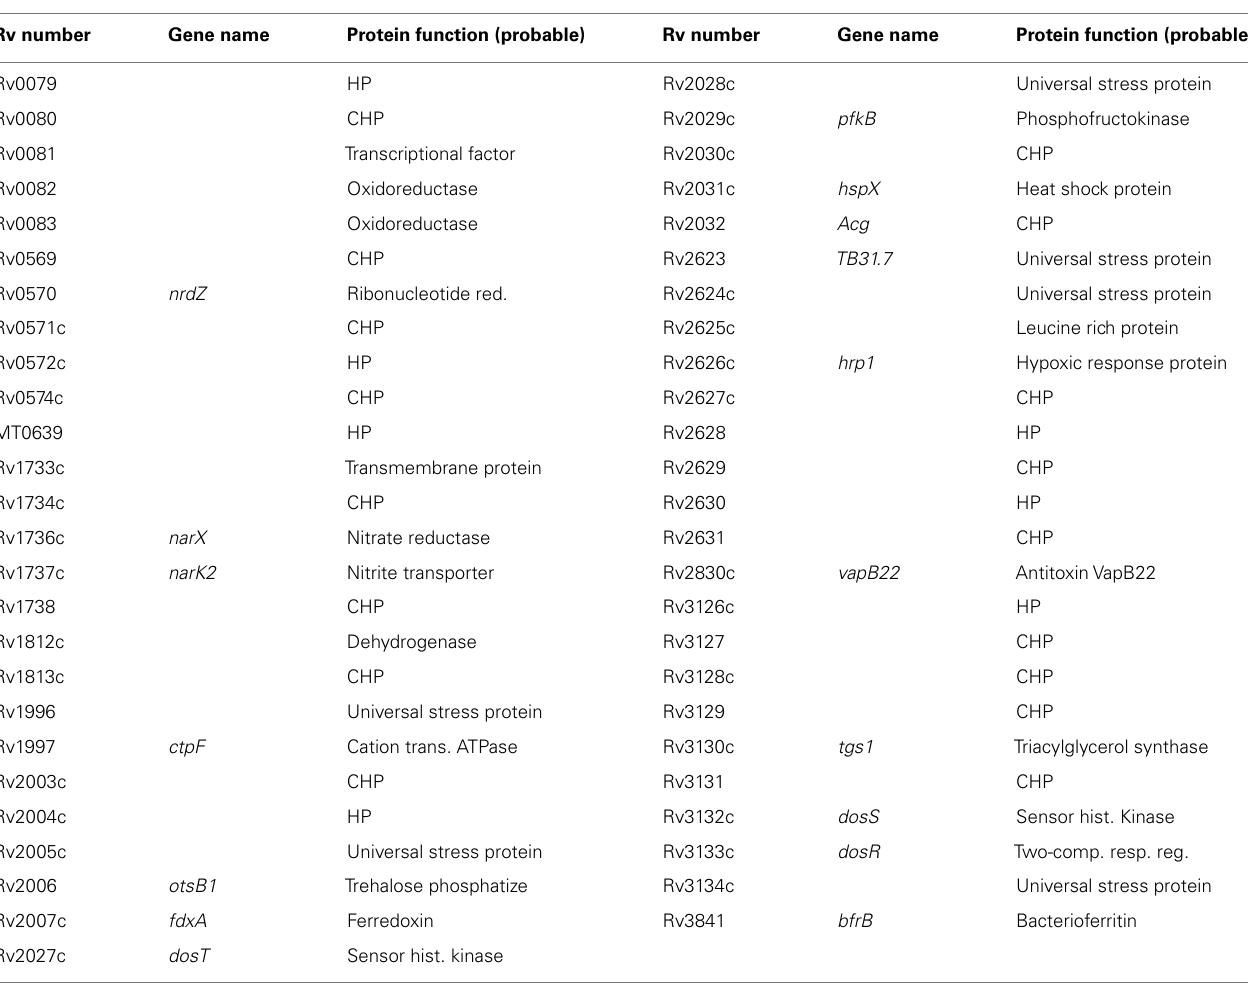
Table 3 | Mtb DosR-regulon